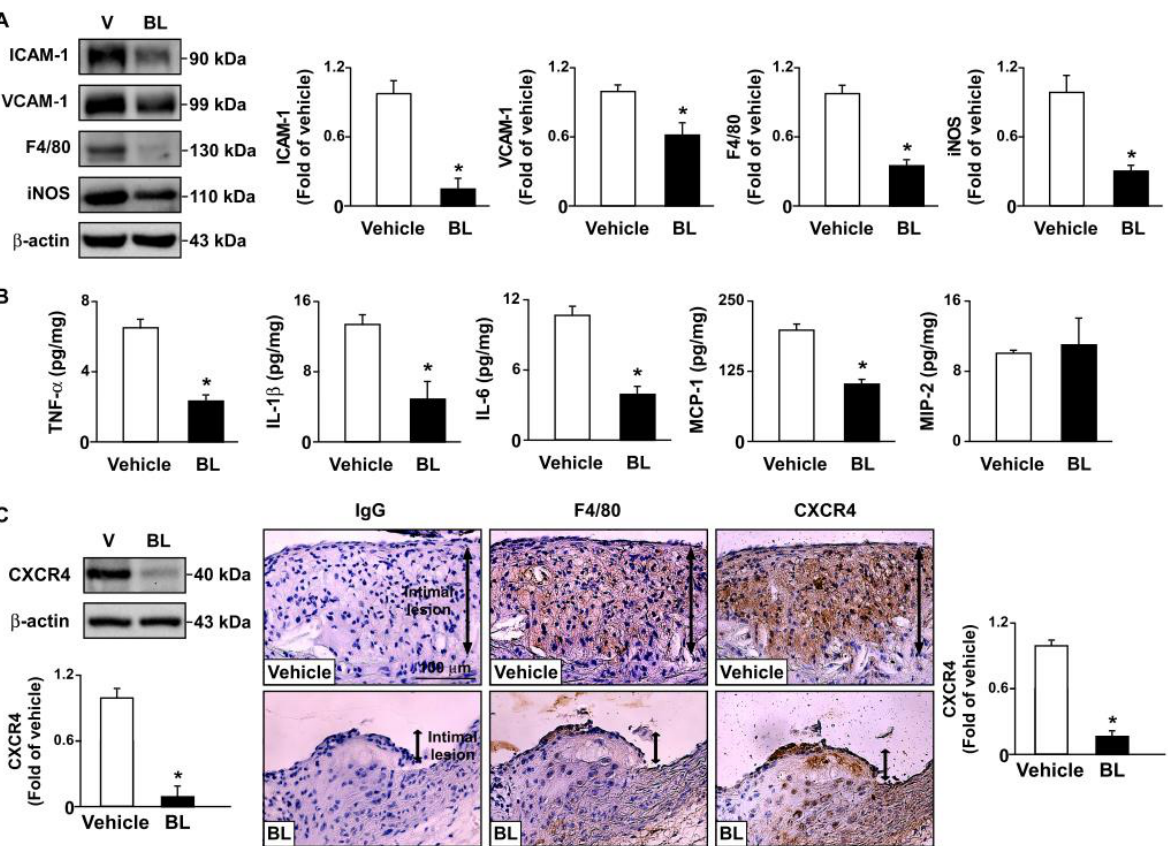
Figure 2. Effects of bromelain on aortic inflammatory response of apoe −/− mice. Male apoe −/− mice were orally administered bromelain (BL, 20 mg/kg/day) or vehicle (PBS) for four weeks. ( A ) Western blot analysis of ICAM-1 and VCAM-1, two endothelial dysfunction markers; F4/80, a macrophage marker; iNOS, an inflammation marker; and β -actin, in the atherosclerotic aortas of bromelain- or vehicle-treated apoe −/− mice. ( B ) ELISA of TNF- α , IL-1 β , IL-6, MCP-1, and MIP-2 in the aortas. ( C ) Western blot analysis of CXCR4 and β -actin in atherosclerotic aortas and immunohistochemistry for CXCR4, the most widely expressed chemokine receptor in physiological and pathological condi- tions. Cell nuclei were stained with hematoxylin. Scale bar = 100 µm. * p < 0.05 vs. vehicle-treated apoe −/− mice.